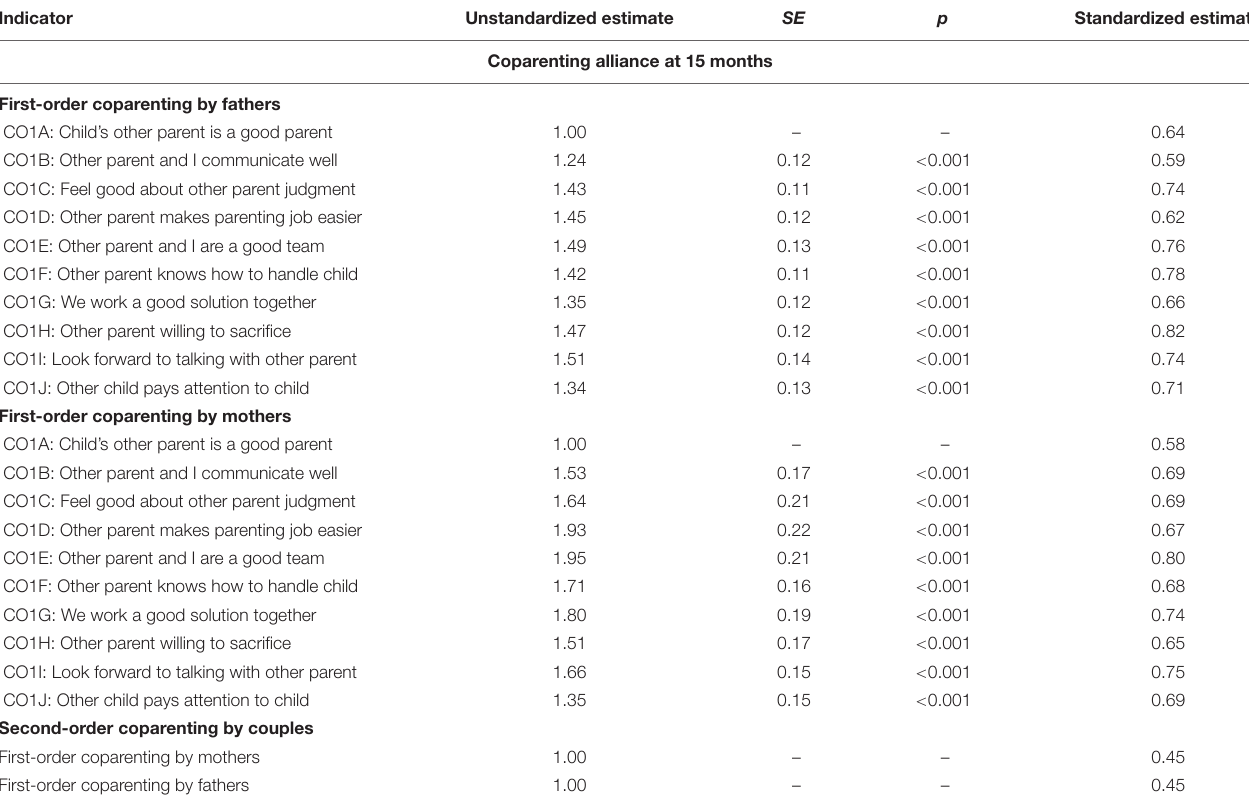
TABLE 4 | Measurement model: Factor loadings for latent variables.